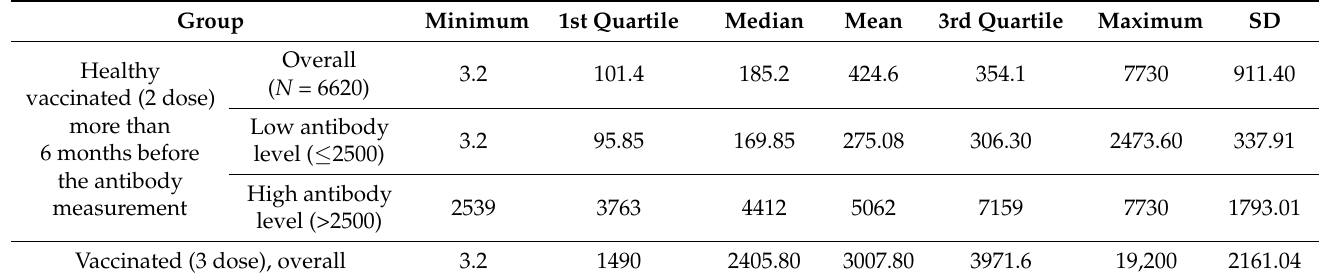
Table 6. A summary of the antibody levels for healthy vaccinated